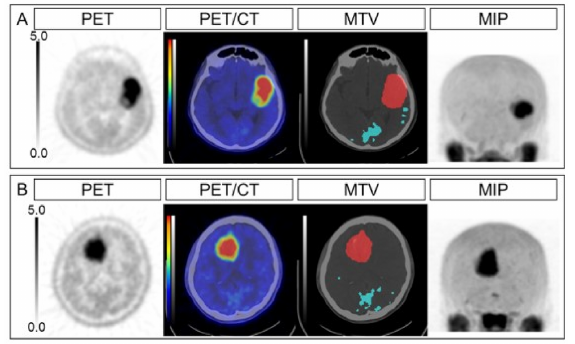
Figure 1. Representative cases. The PET, PET/CT, MTV, and MIP images are shown for an anaplastic astrocytoma case ( A ) and an anaplastic oligodendroglioma case ( B ). The SUVmax values were 7.34 and 6.87, the TNRs were 4.89 and 4.79, the MTVs were 52.7 mL and 56.3 mL, the TLMUs were 170.1 and 229.8, the LGREs were 0.118 and 0.054, and the correlations were 1.27 and 0.89, respectively, for cases ( A ) and ( B ). The overall survival intervals were 4.5 months (dead) and 31.6 months (surviving). PET, positron emission tomography; MTV, metabolic tumor volume; MIP, maximum intensity projection; SUVmax, maximum standardized uptake value; TNR, tumor-to-normal ratio; TLMU, total legion methionine uptake; LGRE, low gray-level run